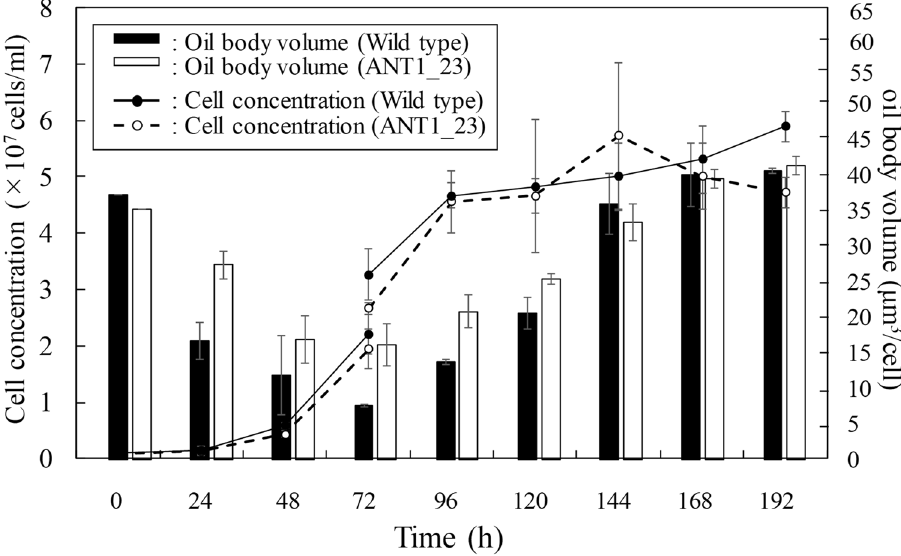
Figure 5. Time-course variation of cell concentration and oil body volumes in F. solaris wild-type (WT) and transformant ANT1_23 in two-stage growth system. Cultured cells were transferred to the nutrient-deplete medium at 72 h. Values are means ± SD of three independent